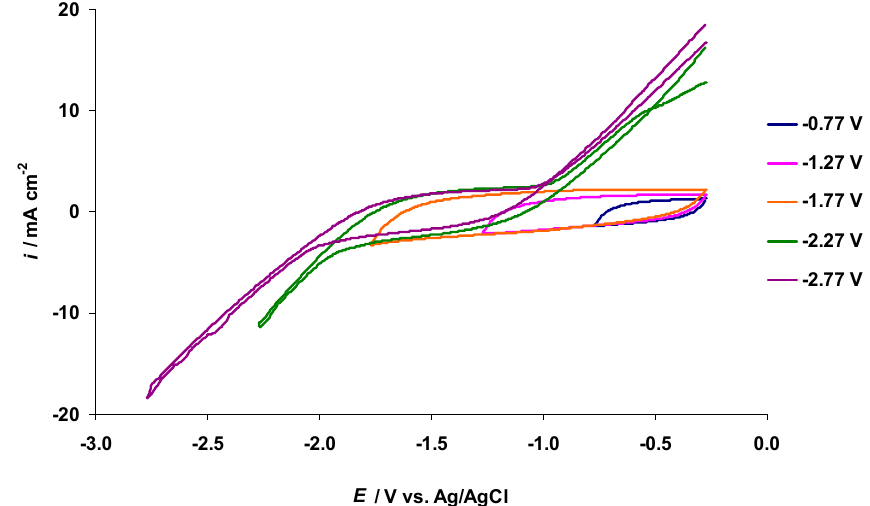
Figure 4. Cyclic voltammetry (CV) curves for negatively polarized C(Mo 2 C) electrode in the 5 wt % EMImBr solution in EMImBF 4 measured at variable potential ranges and normal pressure in the Ar-filled glove box conditions (second CV scans are presented starting and ending at E = − 0.27 V, and the potential scan rate was 1.0 mV s − 1 ).